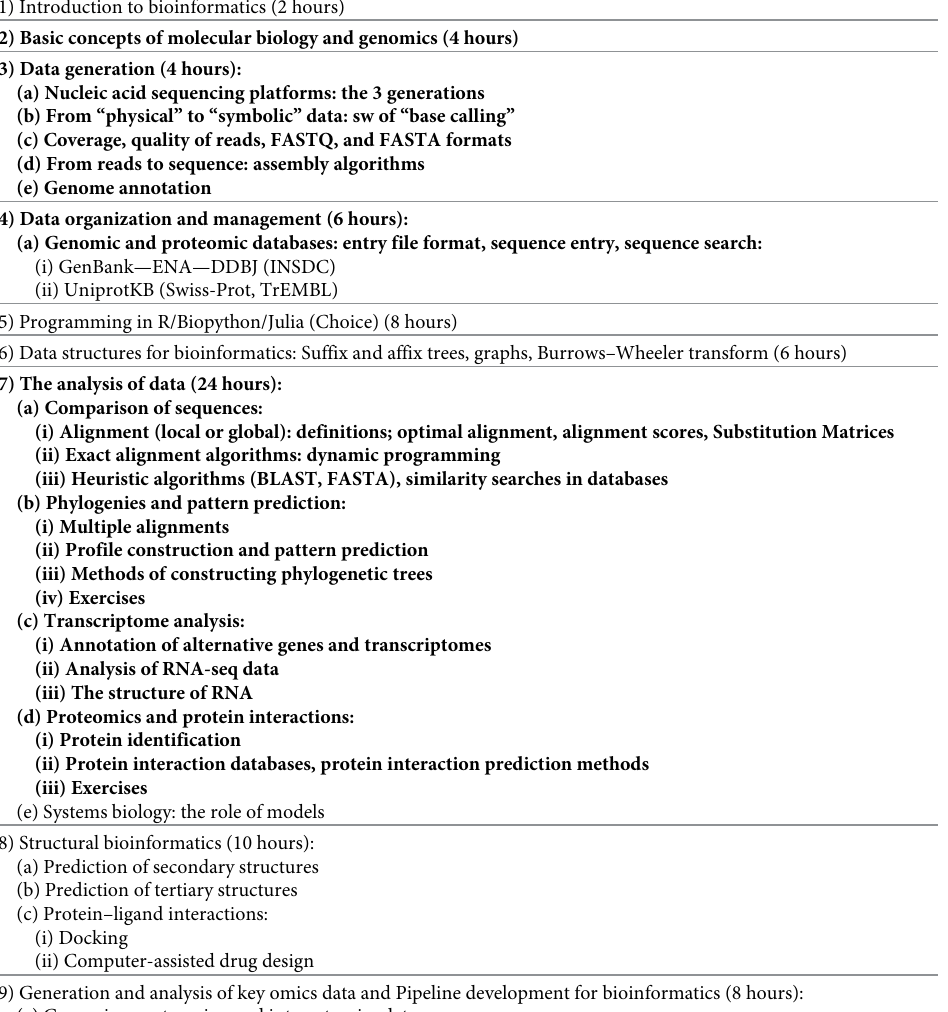
Table 5. Recommended contents for bioinformatics courses embedded in a study path belonging to an MSc degree in the computer science-engineering scientific